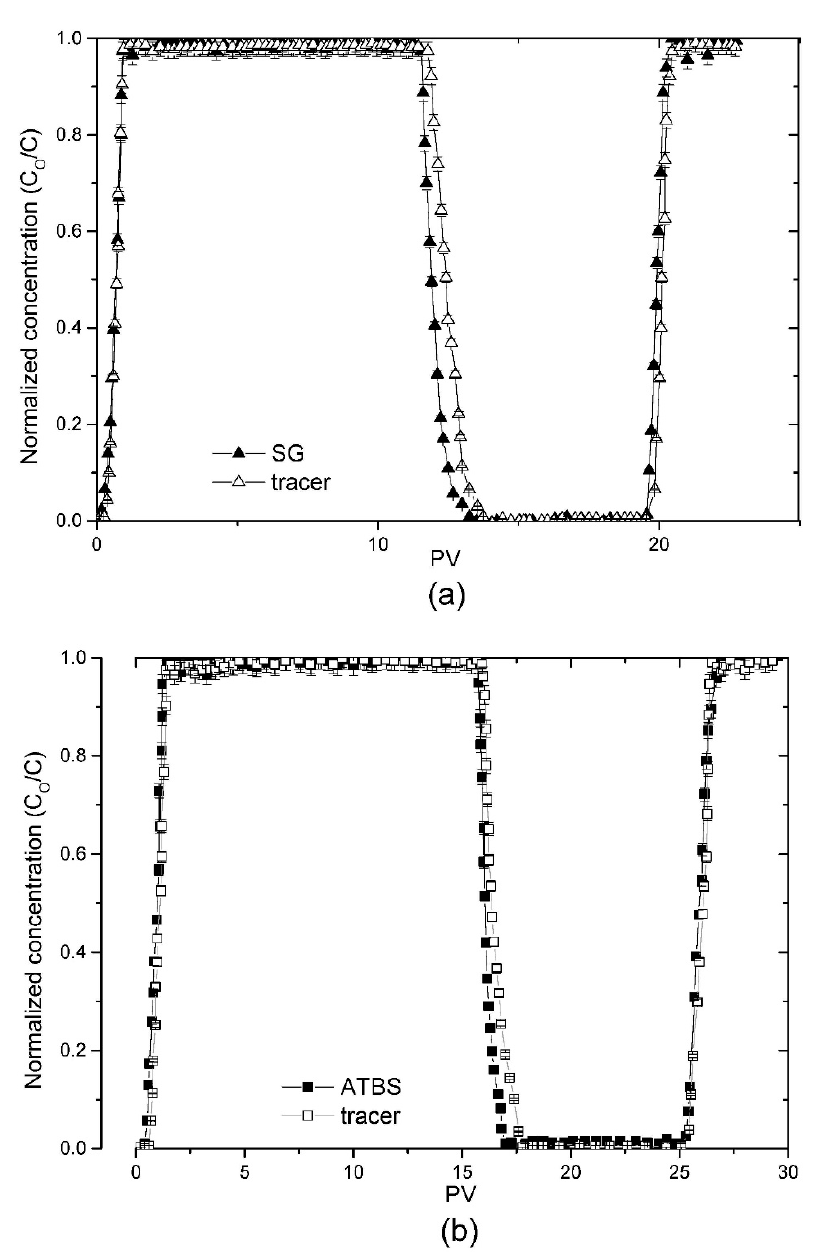
Figure 3. Normalized concentration of polymer and tracer (KSCN at 30 mgL − 1 ) for ( a ) Scleroglucan (SG at 935 mgL − 1 ) and ( b ) sulfonated polymer (ATBS at 2000 mgL − 1 ) at Sorw conditions (2500 psi overburden pressure, 500 psi of backpressure and 212 °F) in a representative core plug.